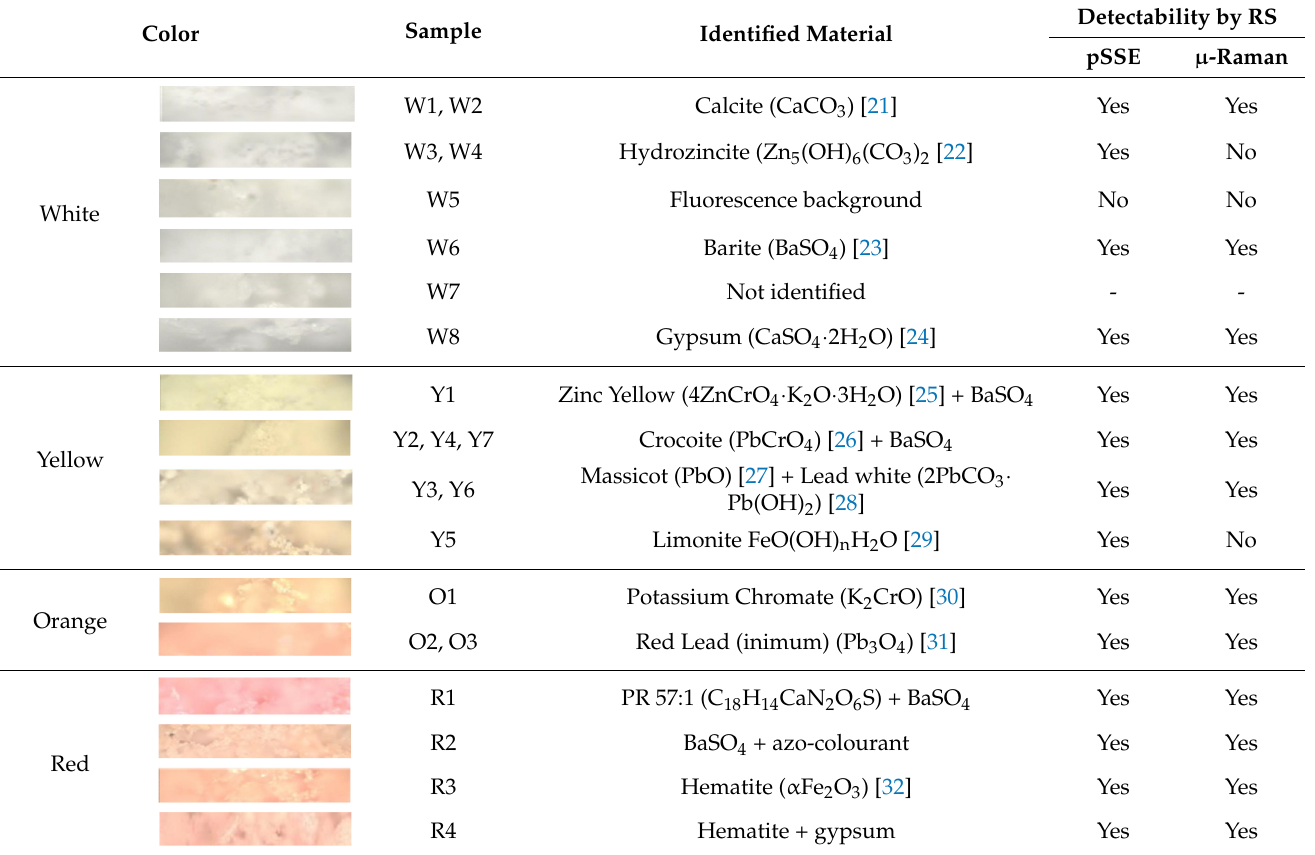
Table 2. The color hue, the sample name, and the composition as identified through the glass vials. The last two columns indicate the outcome of the portable BRAVO and benchtop measurements.